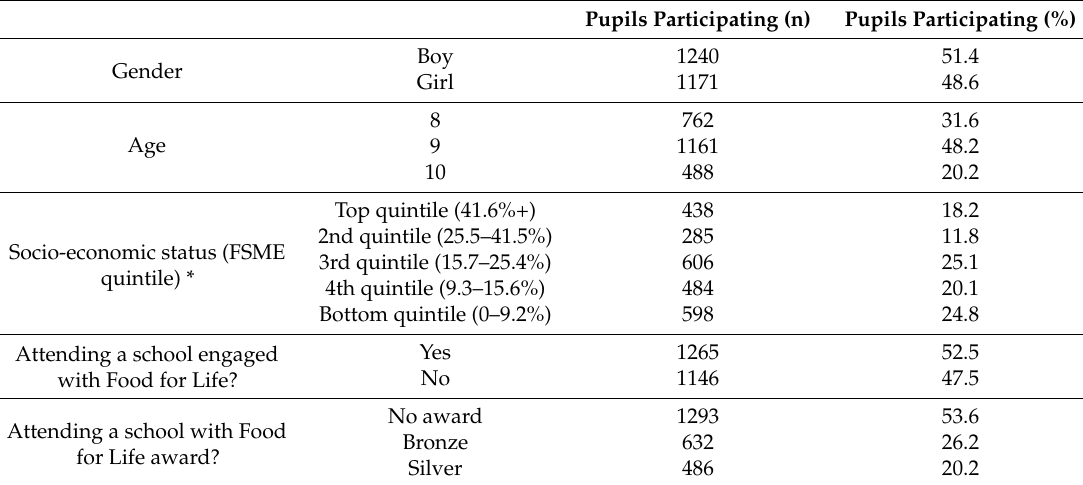
Table 3. Characteristics of pupils in the whole study sample (n =